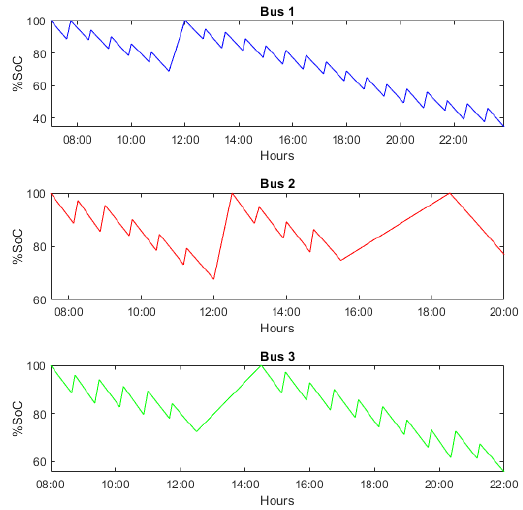
Figure 18. SOC of the three buses with two Opp Chargers of 350 kW.